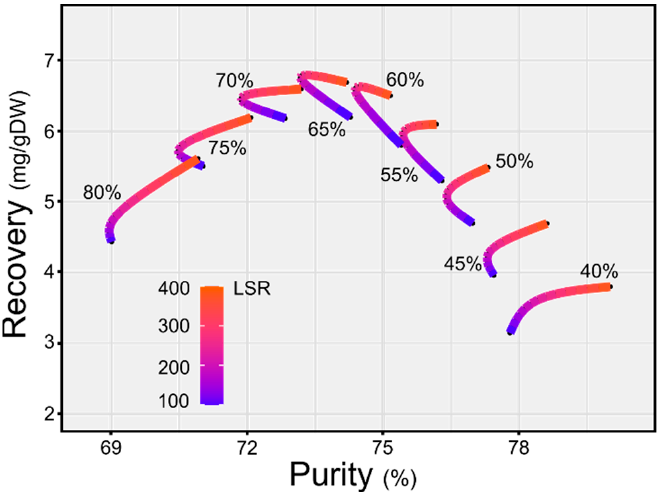
Figure 6. Predicted purity–recovery graph for JB extraction from L. austriacum HR with a ethyl methyl ketone/water mixture. Values were obtained with two models for LSR ranging from 100 to 400 and different solvent/water ratios, from 40 to 80%.